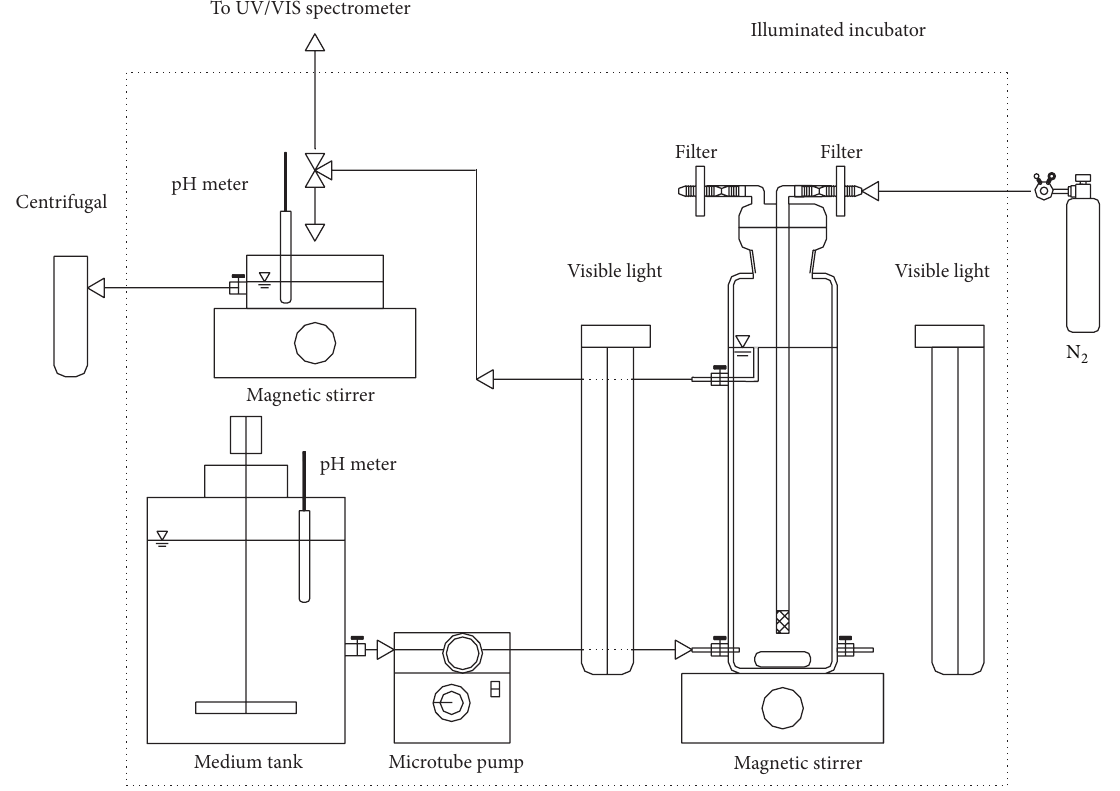
Figure 1: Experimental scheme of continuous cultivation in this